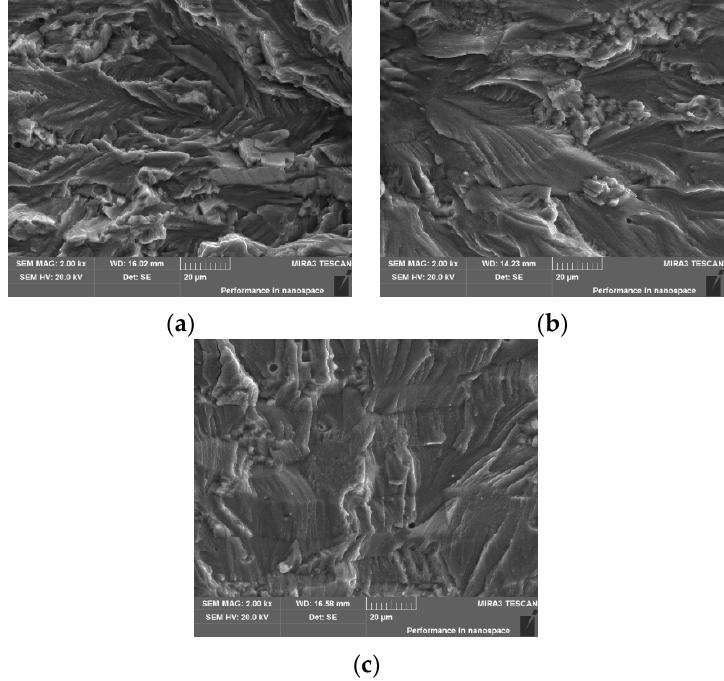
Figure 3. Fatigue source area: ( a ) T3; ( b ) AA; ( c ) CA.